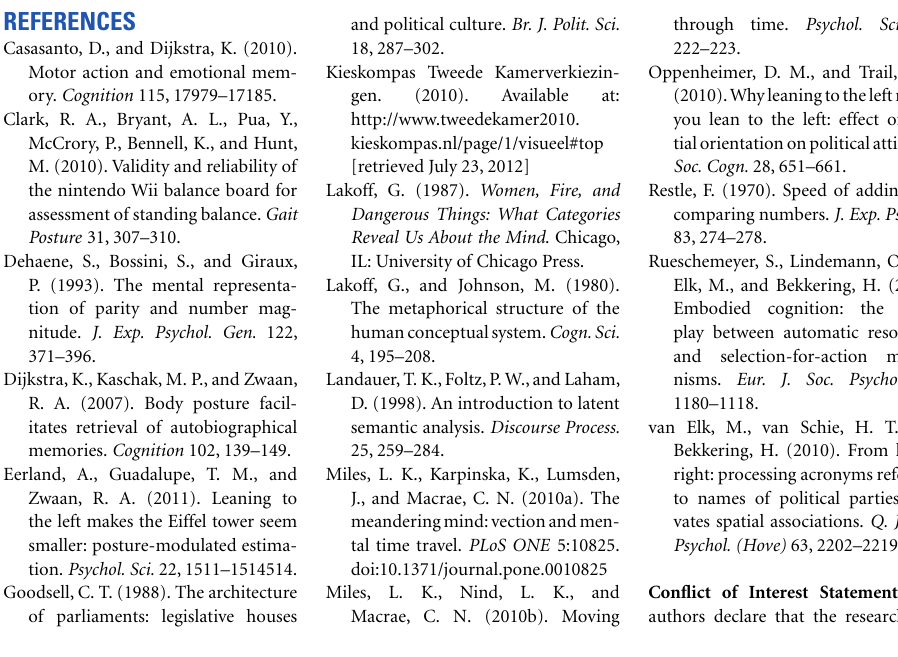
activations. The role of the body on cognitive processes has again been demonstrated and for a somewhat different task as